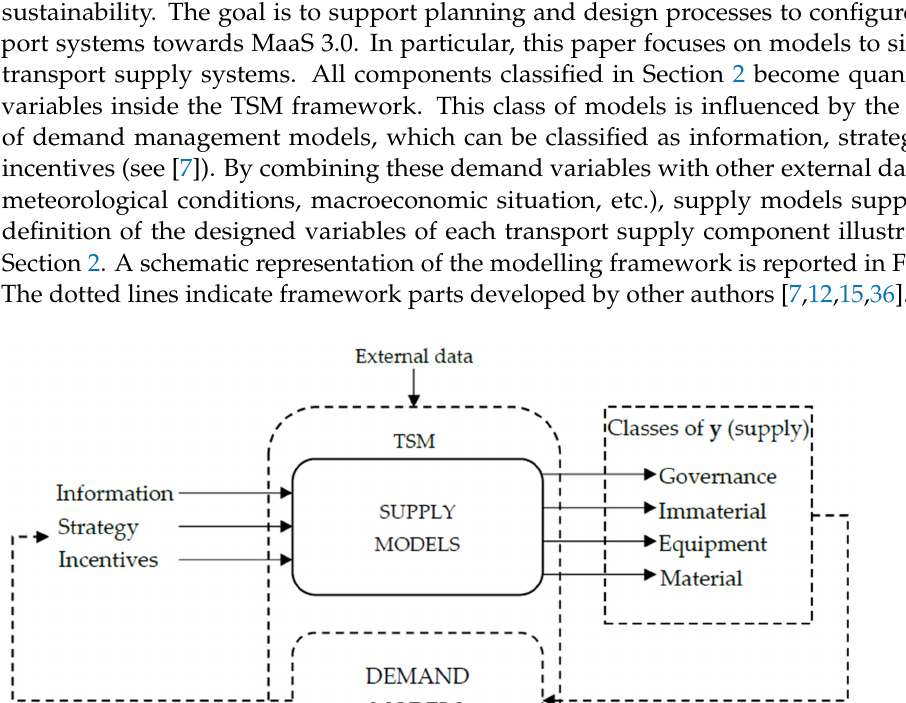
Figure 6. Equipment components.